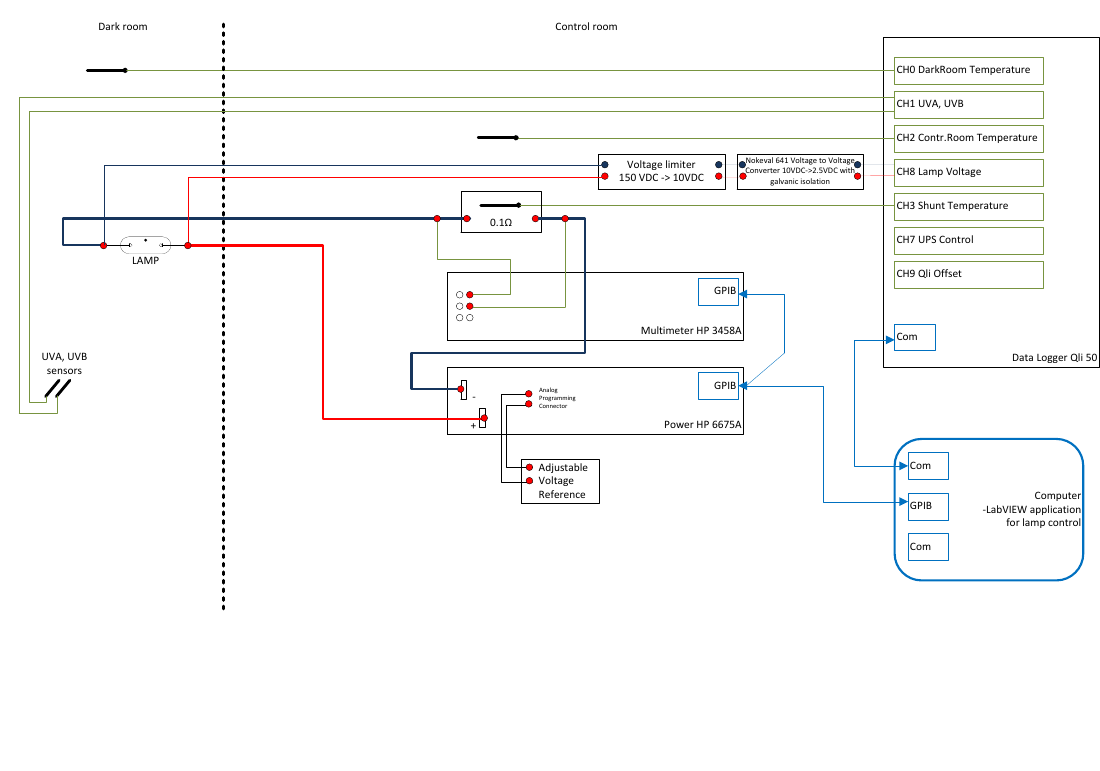
Figure 1. The electrical circuit of the optical laboratory in FMI-ARC. The main circuit is in bold. The vertical black dashed line denotes the separation between the dark room and the control room. Instruments on the left side are in the dark room, while the instruments on the right side are in the control